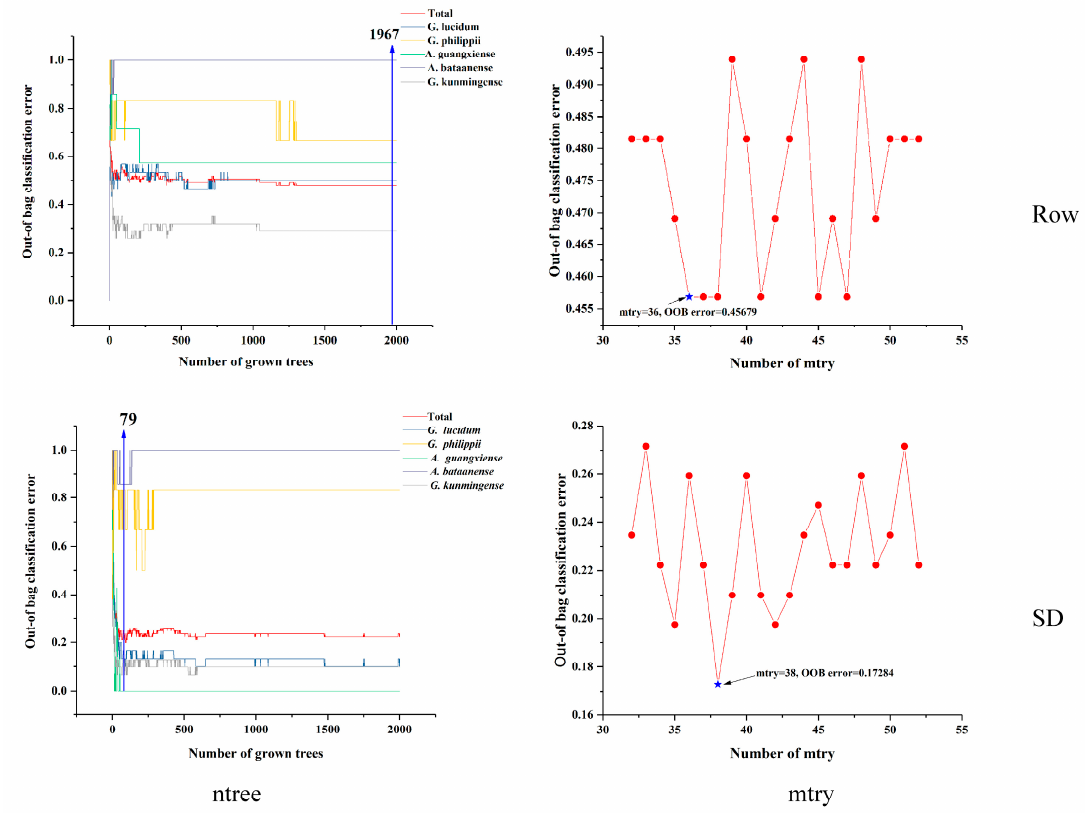
Figure 3. Selection results of tree number and branch node of random forest model using raw and SD spectra.